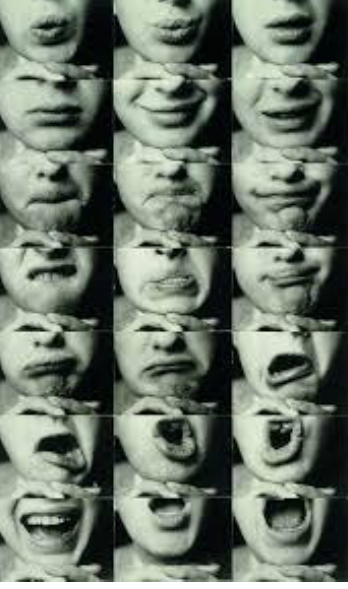
Figure 16 | Kurt Kranz, bacteriasnomeio, 1930s. Figure 17 | Kurt Kranz